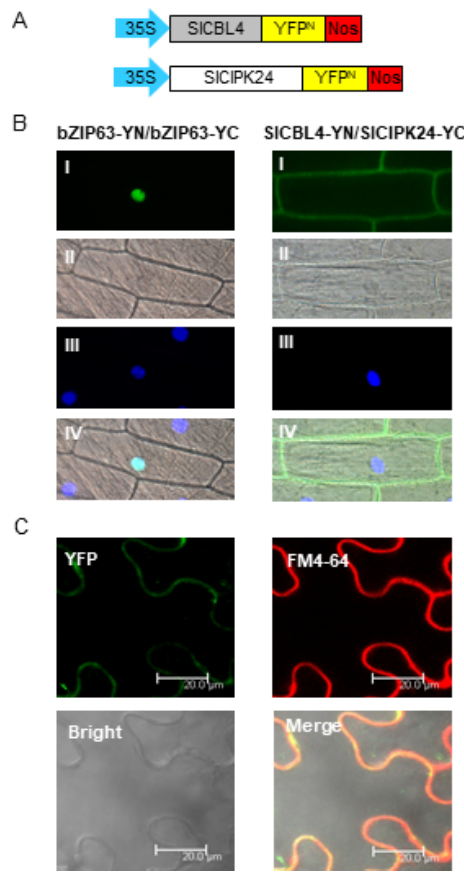
Figure 4. In vivo interaction between SlCBL4 and SlCIPK24. ( A ) Schematic diagrams of SlCBL4-YN ( top ) and SlCIPK24-YC ( bottom ) constructs. ( B ) Bimolecular fluorescence complementation (BiFC) analysis in onion epidermal cells. The indicated plasmids were introduced into the plant cells via the biolistic particle-delivery system. The bZIP63-YFP N and bZIP63-YFP C plasmids were used as a positive control. Following 18-h incubation at 23 ◦ C, the onion cells were analyzed with a fluorescence microscope. I, II and III show images of yellow fluorescence, bright field, and nuclei visualized by 4,6-diamidino-2-phenylindole (DAPI) staining, respectively. IV shows the merged image. ( C ) Images of tobacco ( Nicotiana benthamiana ) leaf epidermal cells infiltrated with Agrobacterium (GV3101) carrying the SlCBL4-YN and SlCIPK24-YC constructs. YFP, FM4-64 and Bright indicate images of YFP, FM4-64 and bright field, respectively. Merge show their merged image.